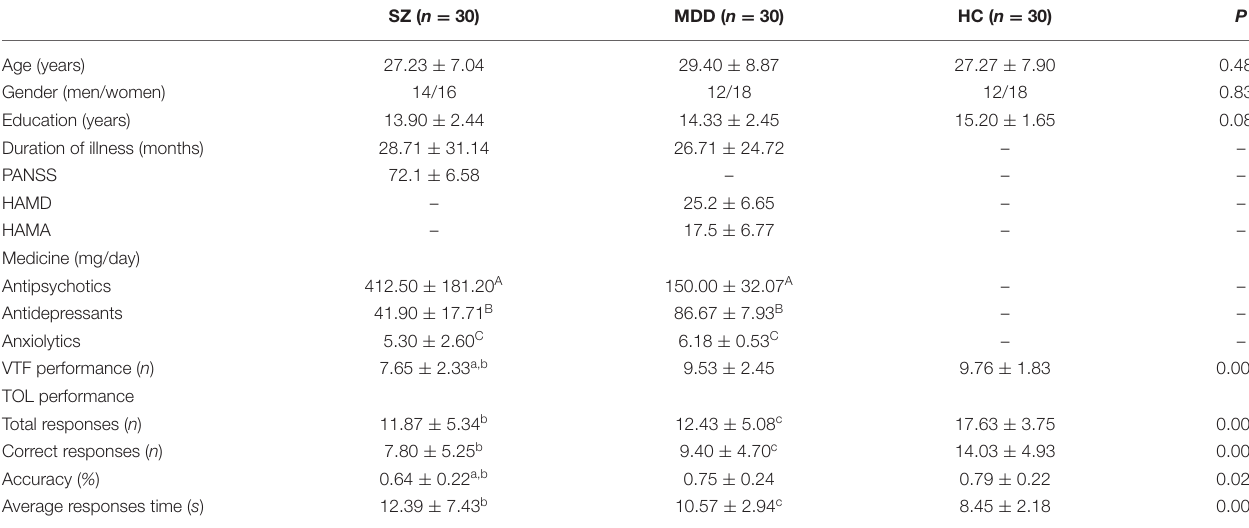
TABLE 1 | Demographics, clinical information, and task